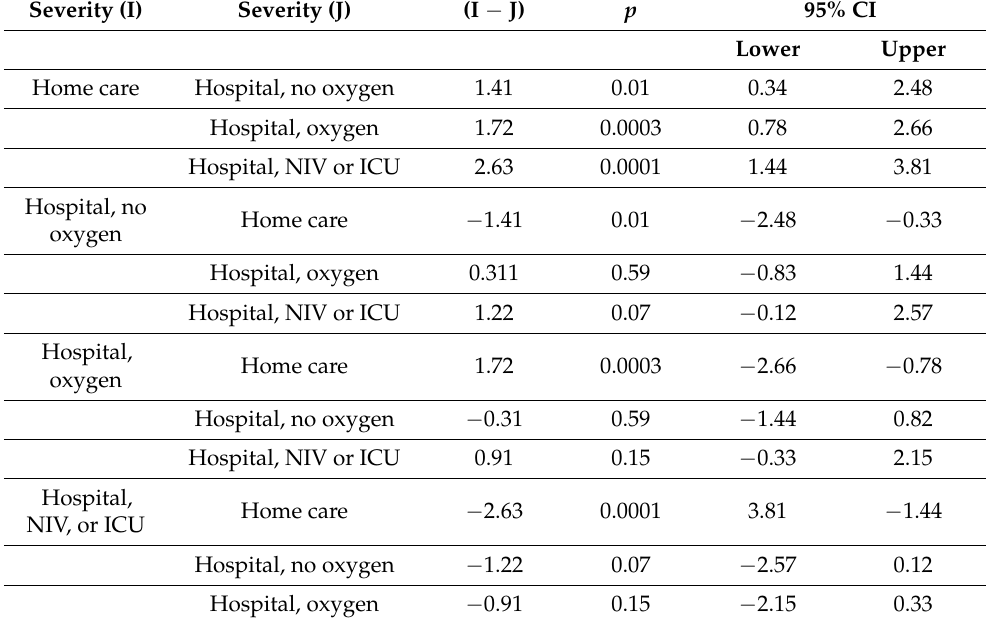
Table 3. Multiple comparisons between COVID-19 categories from analysis of